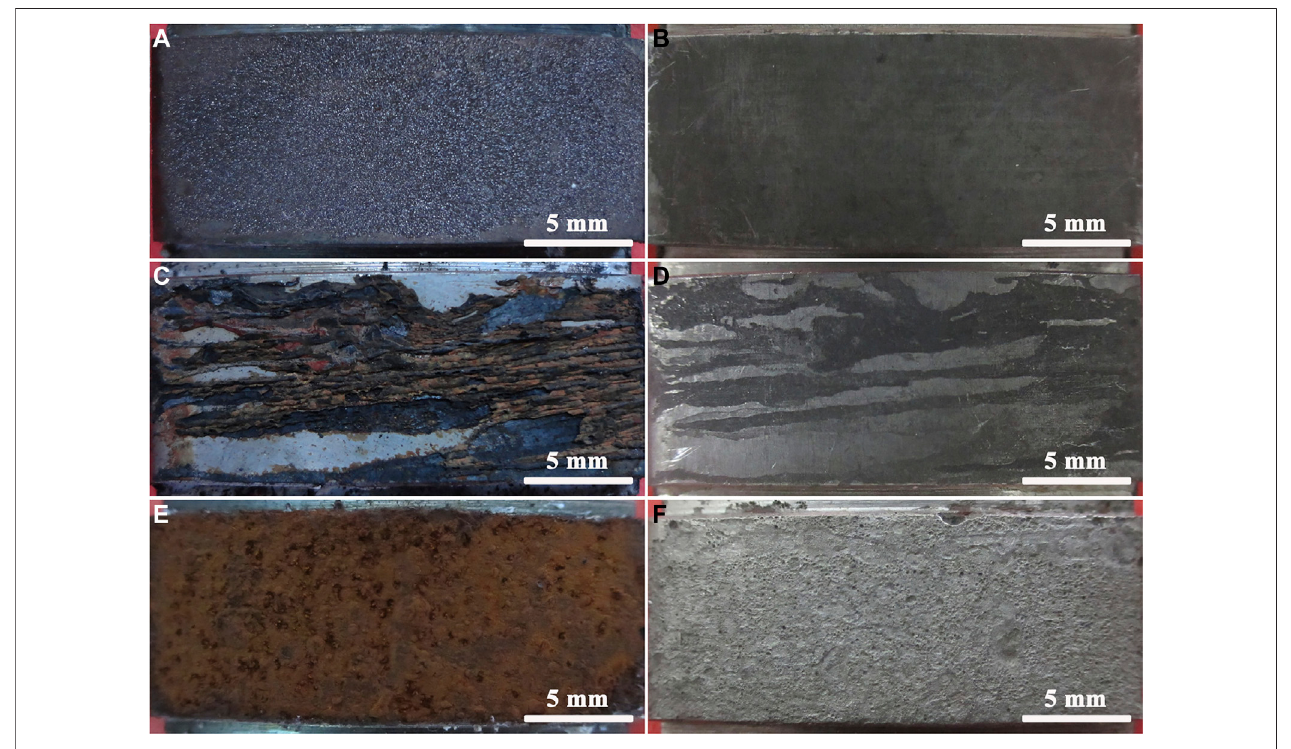
FIGURE 5 | Macro morphologies of the corrosion scale and substrate of N80 steel: (A) Corrosion scale, CO 2 − 2.5 MPa; (B) Substrate, CO 2 − 2.5 MPa; (C) Corrosion scale, O 2 − 0.5 MPa; (D) Substrate, O 2 − 0.5 MPa; (E) Corrosion scale, CO 2 -2.5 MPa, O 2 − 0.5 MPa; (F) Substrate, CO 2 -2.5 MPa, O 2 − 0.5